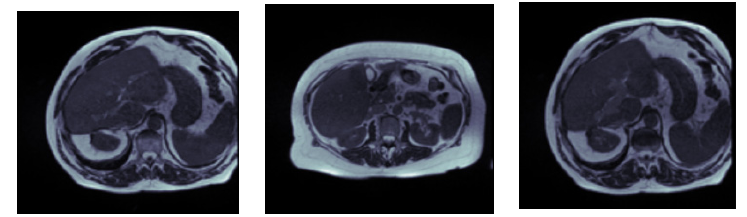
Figure 2. Sample Images of the Dataset.